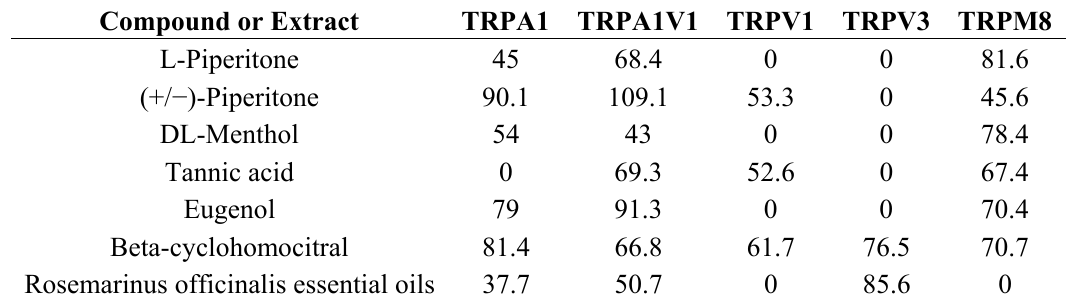
Table 3. Activity of TRPA1, TRPAV1 and TRPV1 agonists towards TRPV3 and